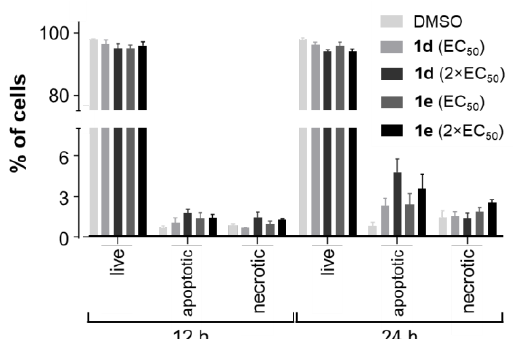
Figure 8. Proportion of apoptotic and necrotic NCI-H522 cells following treatment with 1d and 1e . NCI-H522 (3.0 × 10 5 cells per well) cells were seeded in 6-well plates. NCI-H522 cells were treated with 1× and 2× the EC 50 of 1d and 1e for 12 and 24 h. Vehicle control cells were treated with DMSO (0.5%). Bars indicate the mean number of cells (% of total) ± SEM ( n = 3). Data were analyzed with a two-way ANOVA coupled with a Bonferroni post hoc test. None were significantly different.